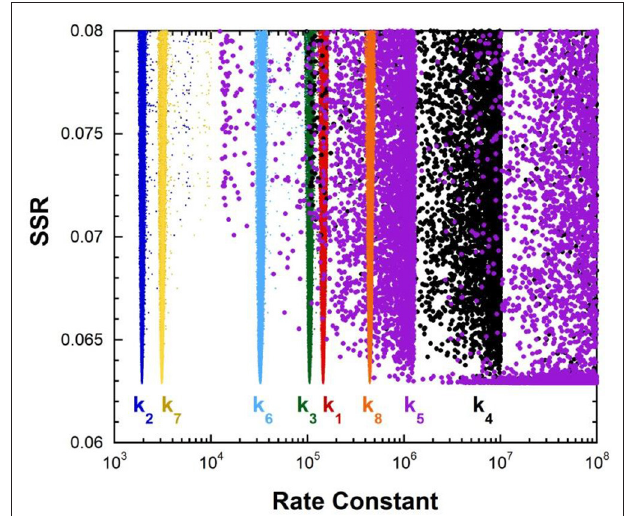
FIGURE 2 | Results of global optimization with mandelate racemase. SSR, sum of squared residuals of the fit to the target function. Each point results from an independent optimization run. The figure was generated from ∼ 40,000 independent runs, each starting from randomized sets of rate constants. The inset presents the intrinsic kinetic isotope effect resulting from global optimization. The fit to the target function is shows significant sensitivity to the values of k 4 and k 5 when they are < 10 6 s − 1 . Therefore, these are the lower limits on the values of these rate constants.